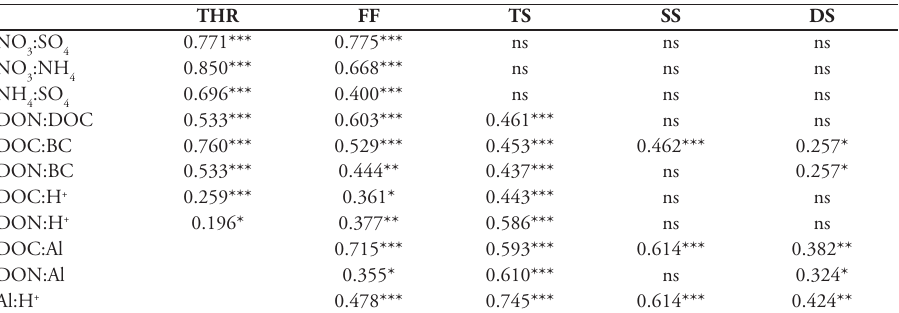
, SO and DON in throughfall 3 4